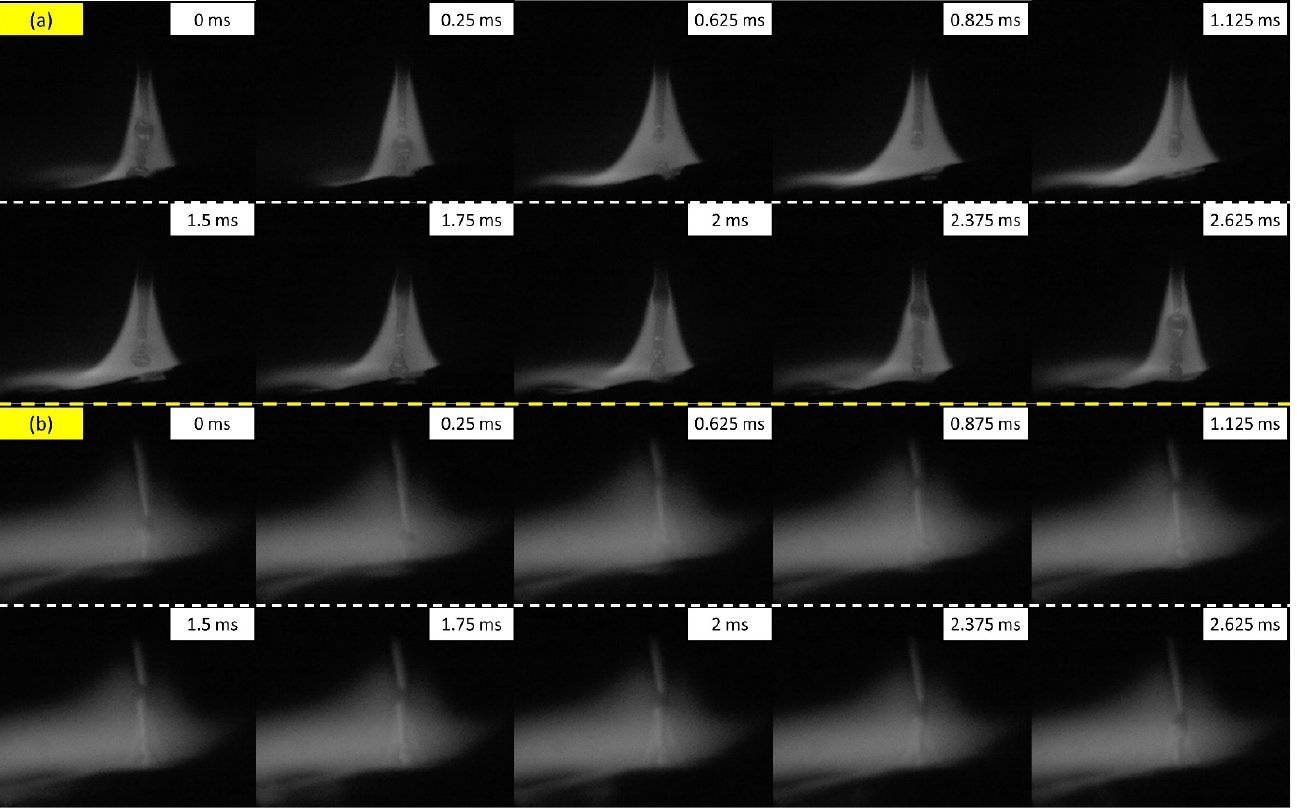
Figure 5. Sequential video images observed with Fe I filter ( a ) and Ar I filter ( b ) of solid wire at 280 A welding current.